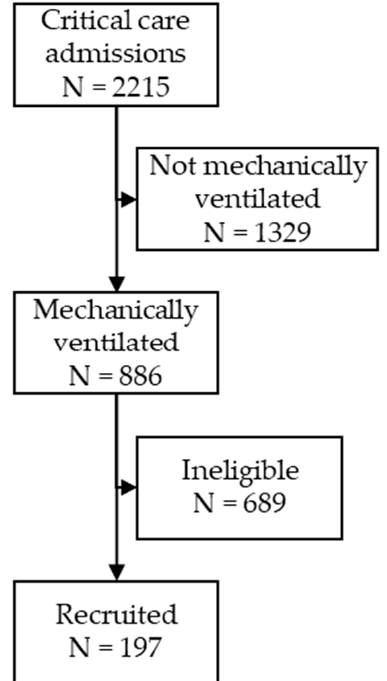
Figure 1. Prevalence and Outcome of Acute Hypoxemic Respiratory Failure in Wales (PANDORA- WALES) recruitment flow chart and eventual study sample. Mechanically ventilated patients who fulfilled study criteria of PaO2 / FiO2 ≤ 300 mmHg on invasive mechanical ventilation with a Positive End-Expiratory Pressure (PEEP) of 5 cm H2O or more, and with a FiO2 of 0.3 or more were included in the study. All other patients were ineligible.